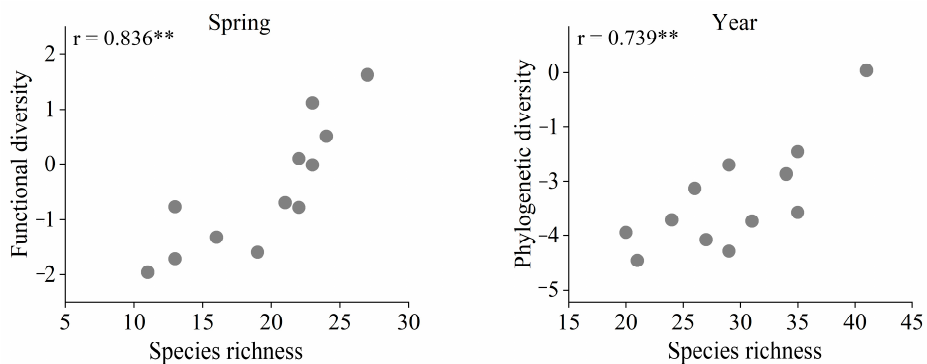
Figure 4. The relationships between species richness and the functional and phylogenetic diversity of bird communities in spring and over the whole year. The strength of the relationship is expressed as Pearson’s correlation coefficient, r (** p < 0.01). Non-significant relationships are not shown in this figure.